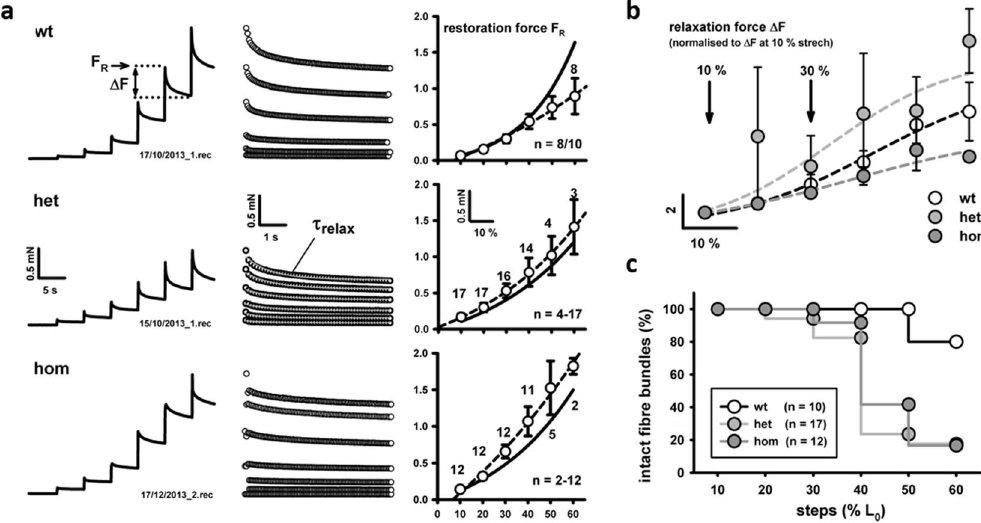
Figure 7. Visco-elastic properties of small fiber bundles from soleus muscles of young Des R349P knock-in mice. ( a ) Representative example recordings of passive force during fast length-extension jumps in 10% of L 0 intervals. Fiber bundles were acutely stretched and kept at that length for 5 s before proceeding to the next 10% stretch (range: 10–60% L 0 ). Force responses at each step consist of an instantaneous restoration force (F R ) followed by a relaxation phase during which force declined to a plateau. The F R values, time constants during exponential force relaxation ( τ relax ) and Δ F during relaxation were analyzed. F R -length relations are much steeper in the Des R349P mutated preparations over the wt and are steeper for the hom over the het mutation (right panel in ( a ): solid line refers to mean exponential curve reconstructed from the mean parameters of each individual curve fit; dashed line refers to exponential fit through the mean data). ( b ) Δ F- Δ L relationships showing the mean relaxation data for each genotype. Those indicate a more reduced relaxation in the hom genotype than in the wt. ( c ) Maier-Kaplan curves showing the percentage of still intact bundles at a given stretch